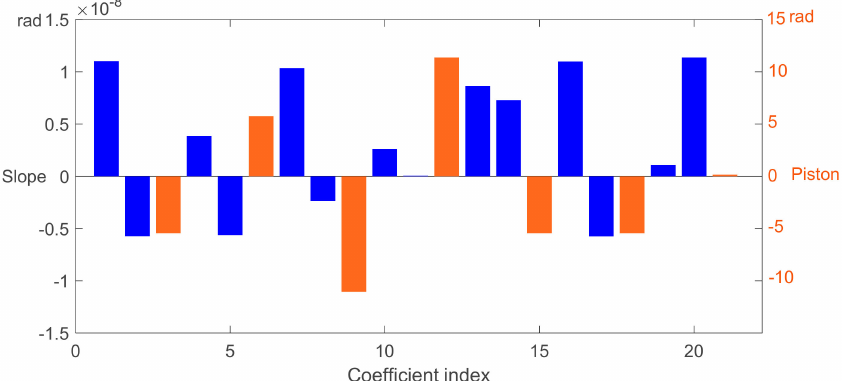
Figure 6. Difference between the retrieved coefficients and those of the ground truth.